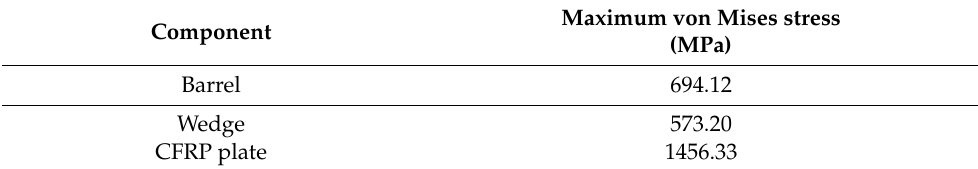
Figure 7. Von Mises stress distribution. Table 2. Finite element analysis results.